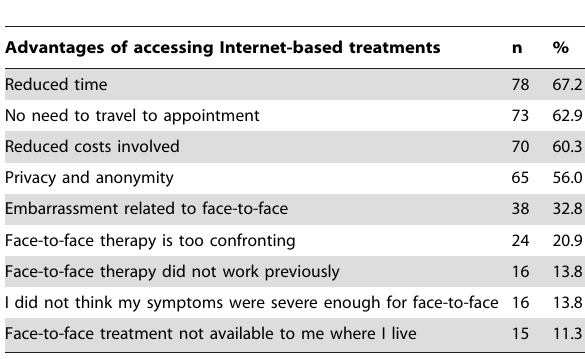
Table 2. Perceived advantages of Internet-based treatments reported by the Internet Survey group (N